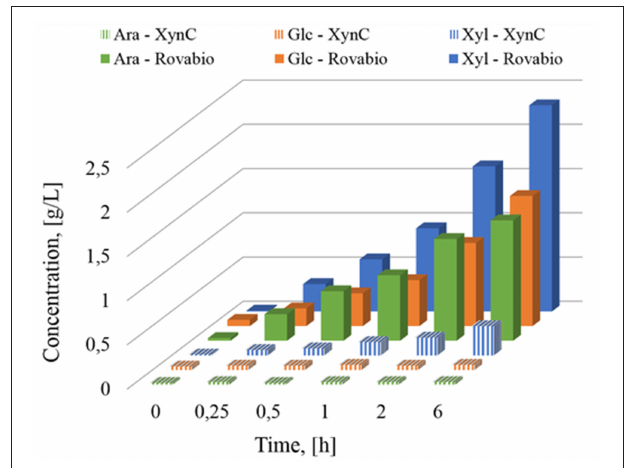
FIGURE 7 | Determination of monosaccharides solubilized (g/L) during treatment of destarched wheat bran by Rovabio ® or by XynC at equivalent activity to 400 U xylanase visco